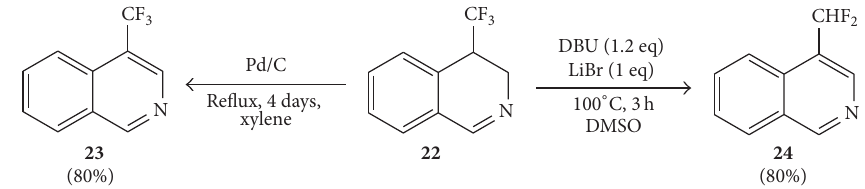
Scheme 8: Preparation of 4-trifluoromethyl- and 4-difluoromethylisoquinolines.